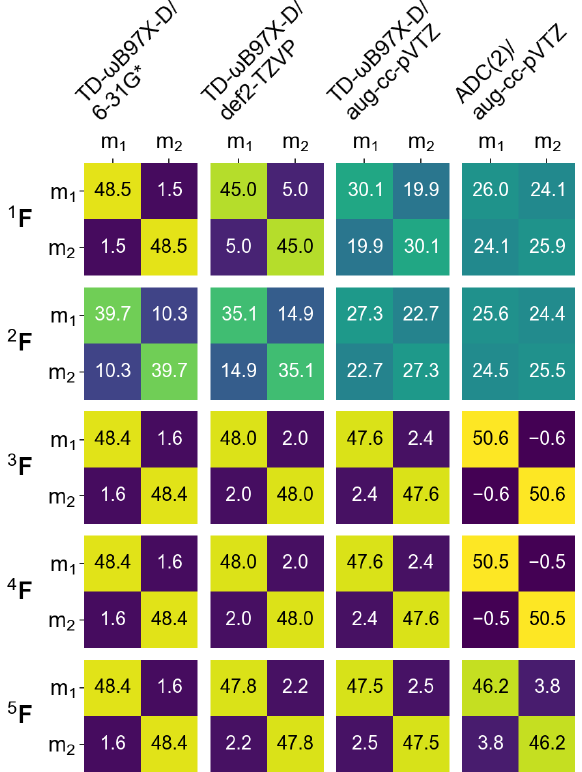
Figure 7. FTDM matrices 1 F , . . . , 5 F for the S 0 → S 1 transition of the cofacial π -stacked dimer d = 3.5 Å calculated with four methods indicated in the top. X , Y = m 1 ,m 2 ; m stands for